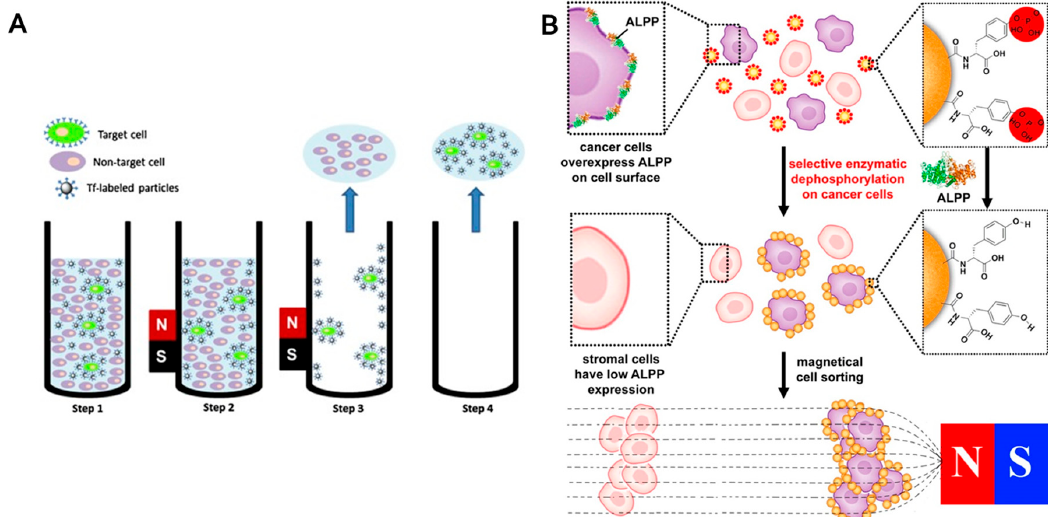
Figure 5. Different approaches to cells sorting. ( A ) Scheme of cell separation using magnetic particles. Target cells are bounded to magnetic particles modified with transferrin as a targeting moiety (step 1). Cells are magnetically separated (step 2). Non-targeted cells are removed with supernatant (step 3). Subsequently, target cells are resuspended and removed (step 4). (Reproduced with permission from [202]); ( B ) Enzymatic transformation of magnetic particles for selective sorting of cancer cells (reproduced with permission from [198]). ALPP: placental alkaline phosphatase.